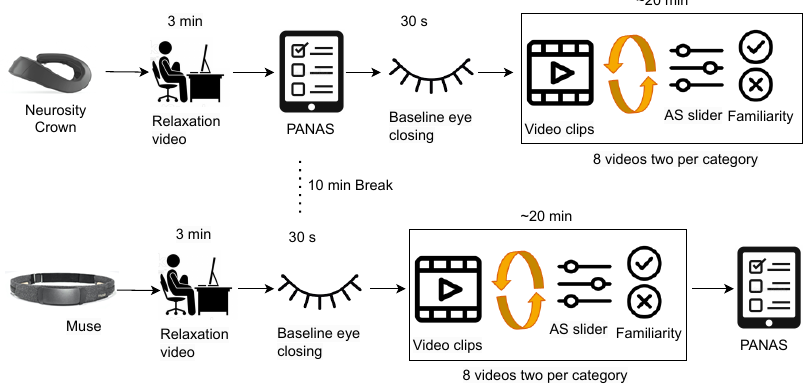
Figure 4. Experimental setup for curating Dataset II. The participants watched a relaxation video at the beginning and eight videos, two of each dimension category wearing one of the two devices. Between the eight videos, they answered AS slider and familiarity with the